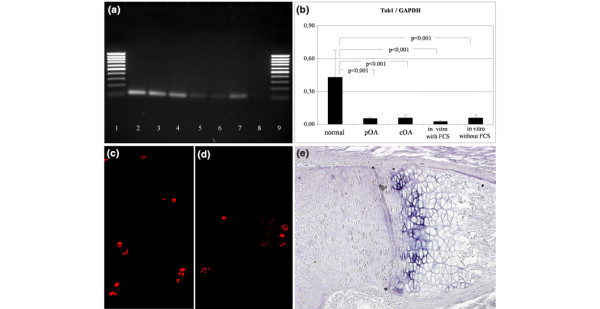
Tob1 expression in fetal, normal and osteoarthritic cartilage (PCR, immunostaining, in situ hybridization). (a) Conventional PCR demonstrates the expression of Tob1 in normal and (at a reduced level) in osteoarthritic cartilage samples (lanes 1 and 9, molecular weight standards; lanes 2–4, normal cartilages; lanes 5–7, osteoarthritic cartilages; lane 8, negative control). In all experiments the RNA was directly from the tissue (without isolation of cells before isolation of RNA). (b) Quantitative real-time PCR analysis for mRNA expression levels of Tob1 in normal (n = 10) and peripheral (pOA, n = 8) and central (cOA, n = 7) osteoarthritic cartilage as well as normal adult articular chondrocytes cultured with (n = 6) and without (n = 3) serum. Results are shown as ratios to glyceraldehyde-3-phosphate dehydrogenase. (c, d) Immunolocalization of Tob1 in human normal (c) and osteoarthritic (d) articular cartilage (in both the middle and upper deep zones of the cartilage are shown). (e) mRNA expression analysis of Tob1 in fetal growth plate cartilage of mice, with the use of in situ hybridization: detectable expression levels are restricted to the hypertrophic zone (and osteoblasts).